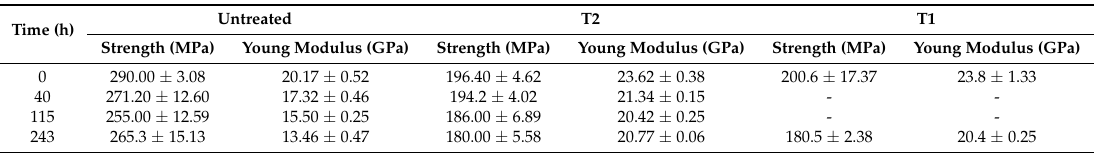
Table 5. Tensile properties in fiber direction of FA treated and untreated composites after water absorption (average and standard deviation).